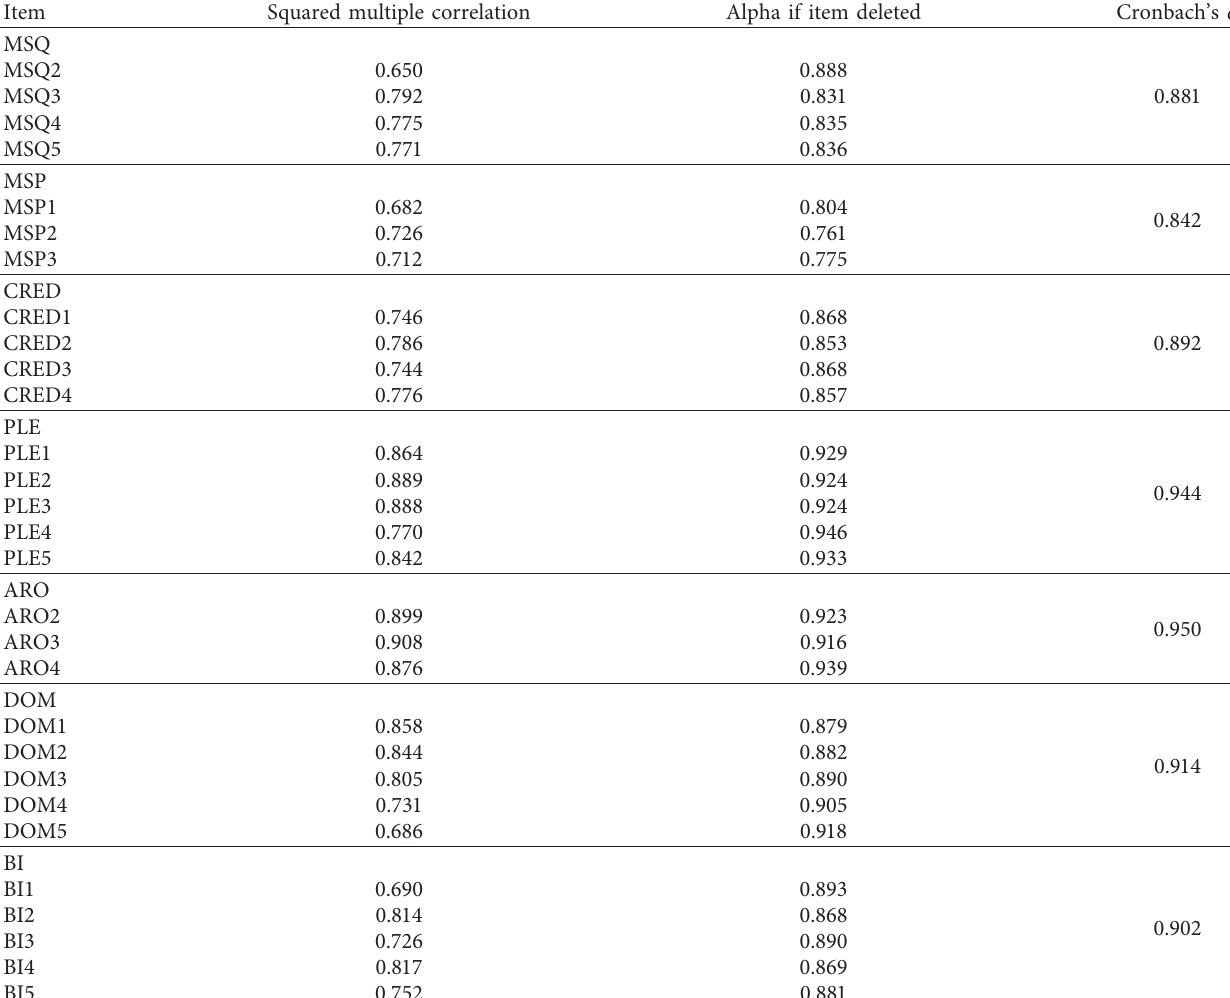
Table 3: The results of the reliability analysis.